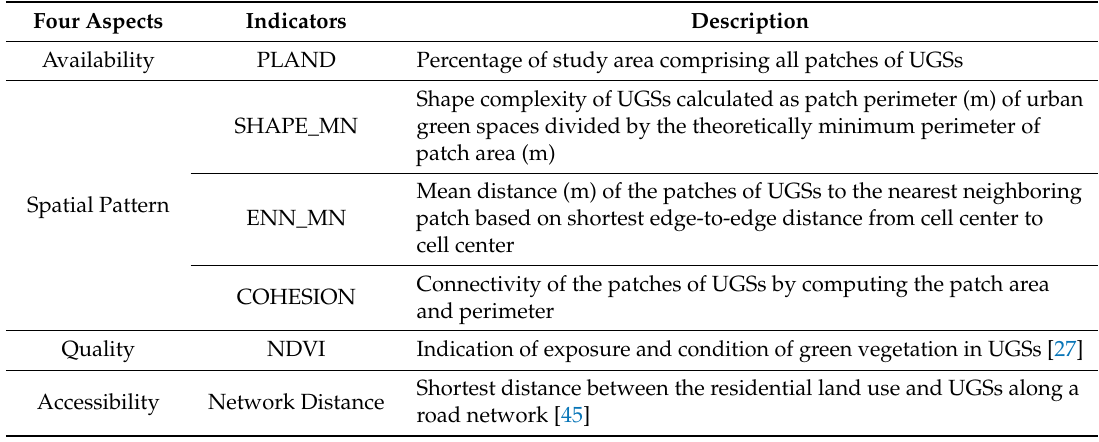
Table 1. Landscape spatial characteristics of urban green spaces